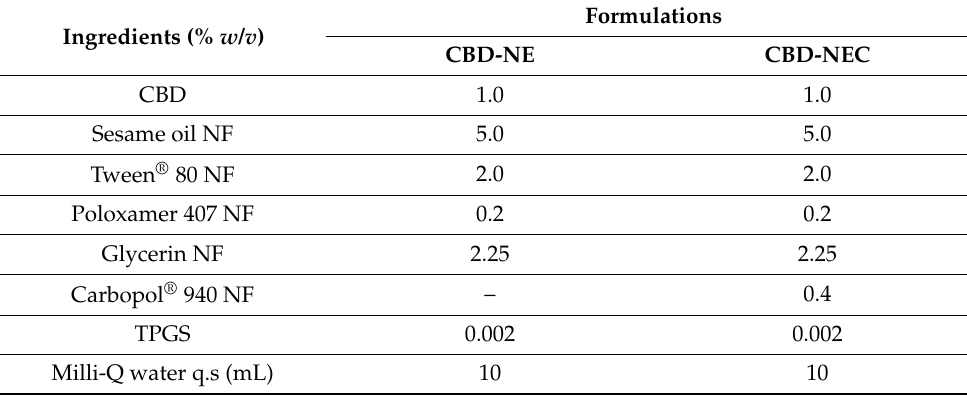
Table 1. Composition of cannabidiol-loaded nanoemulsion